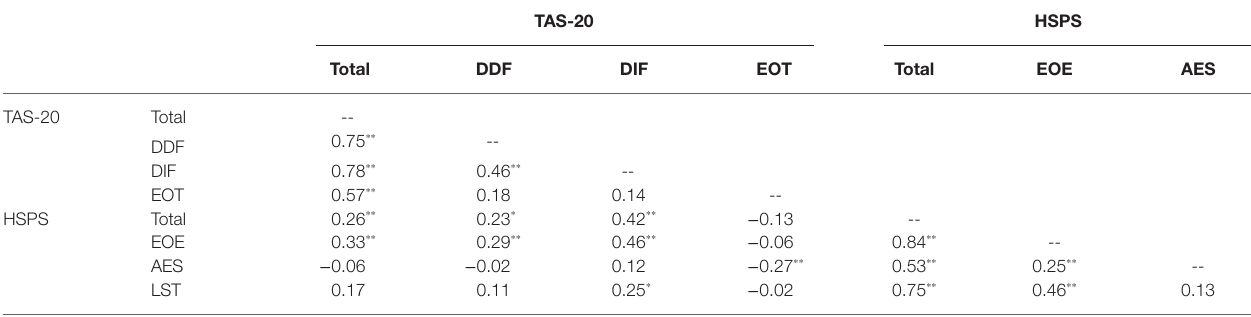
TABLE 1 | Correlations between measures of alexithymia and sensory processing sensitivity (SPS).